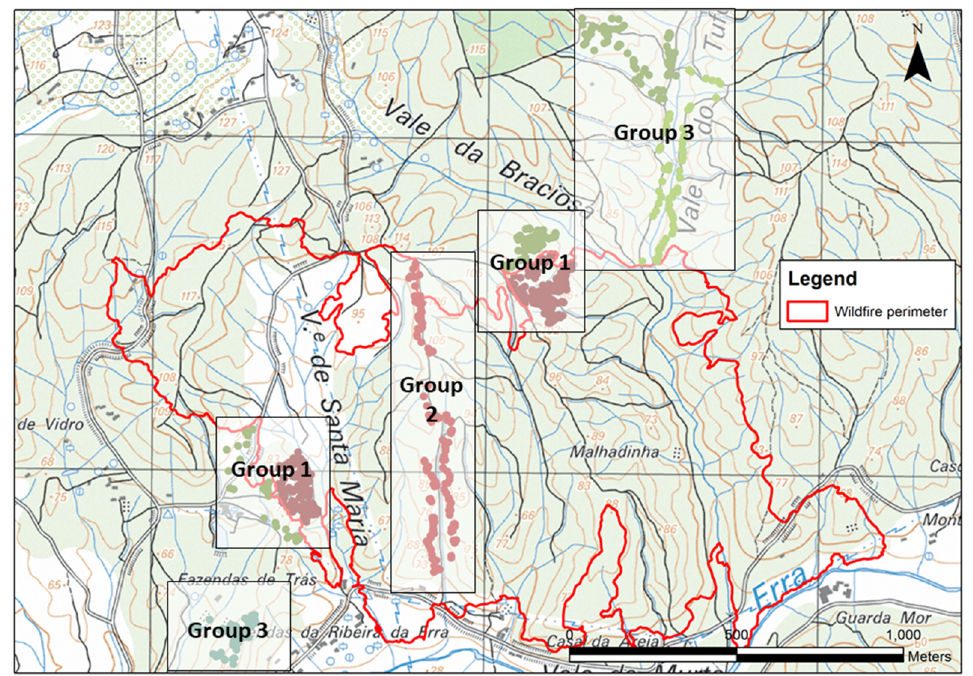
Figure 1. Location of the wildfire perimeter (red line) and of the three major groups of trees used in the current study, comprising 841 burned and unburned cork oaks assessed within and sur- rounding the burned area (burned and unburned trees are represented in a reddish and greenish colour, respectively).